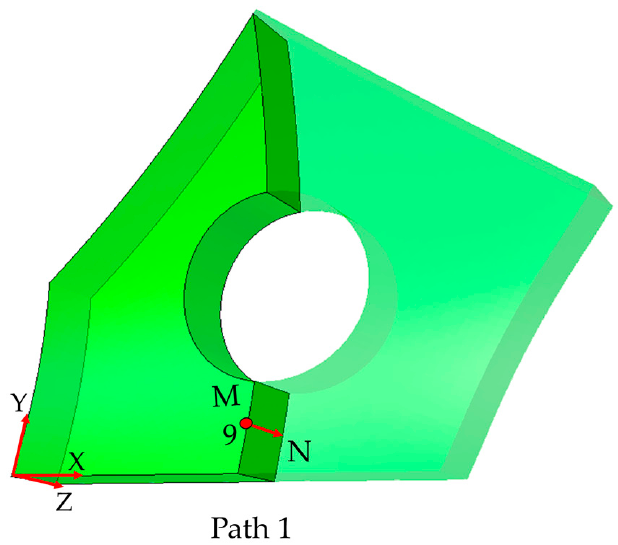
Figure 5. The analysis location of cold expansion rate on quenched residual stress in the forging. The quenched residual stress in the forging was reduced to varying degrees after cold expansion. The distribution of stress in the X-direction ( σ x ), Y-direction ( σ y ), Z-direction ( σ z ), and Mises was observed, as shown in Figure 6. The results revealed that 2% cold expansion rate of was most effective for reducing quenched residual stress. From the result, it could be seen that the magnitude of σ z was within ± 40 MPa, both before and after the cold expansion. However, after quenching, the stress amplitudes of σ x and σ y are relatively large. The forging surface exhibited compressive stress with a maximum compressive stress amplitude of 221 MPa, and the core exhibited tensile stress with a maximum tensile stress amplitude of 205 MPa. After cold expansion, the stress amplitudes of both σ x and σ y were reduced to varying degrees, but still exhibited surface compressive stress with a maximum compressive stress amplitude of 119 MPa, and core tensile stress with a maximum tensile stress amplitude of 125 MPa. After quenching, the von Mises stress along path 1 show a W-shaped distribution (larger values at the surface and in the core of the forging, and smaller values at the quarter thickness), with a maximum value of 227 MPa. After a 2% cold expansion process, the von Mises stress amplitude of the forgings was reduced to below 120